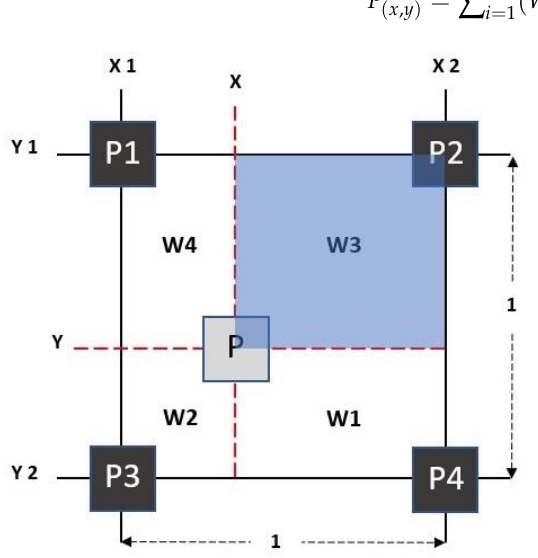
Figure 2. Example of a tetragon with four equal side lengths and angles—this is the same as the traditional bilinear (TB) weighting scheme.